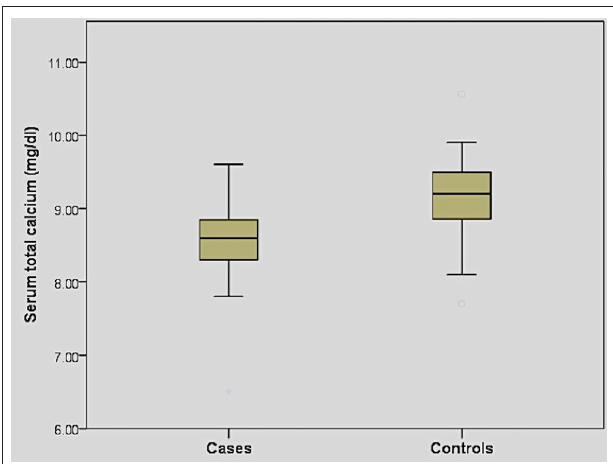
FIGURE 1 | Box and whisker plot showing comparison of serum total calcium in non-severe COVID-19 patients (cases) and healthy